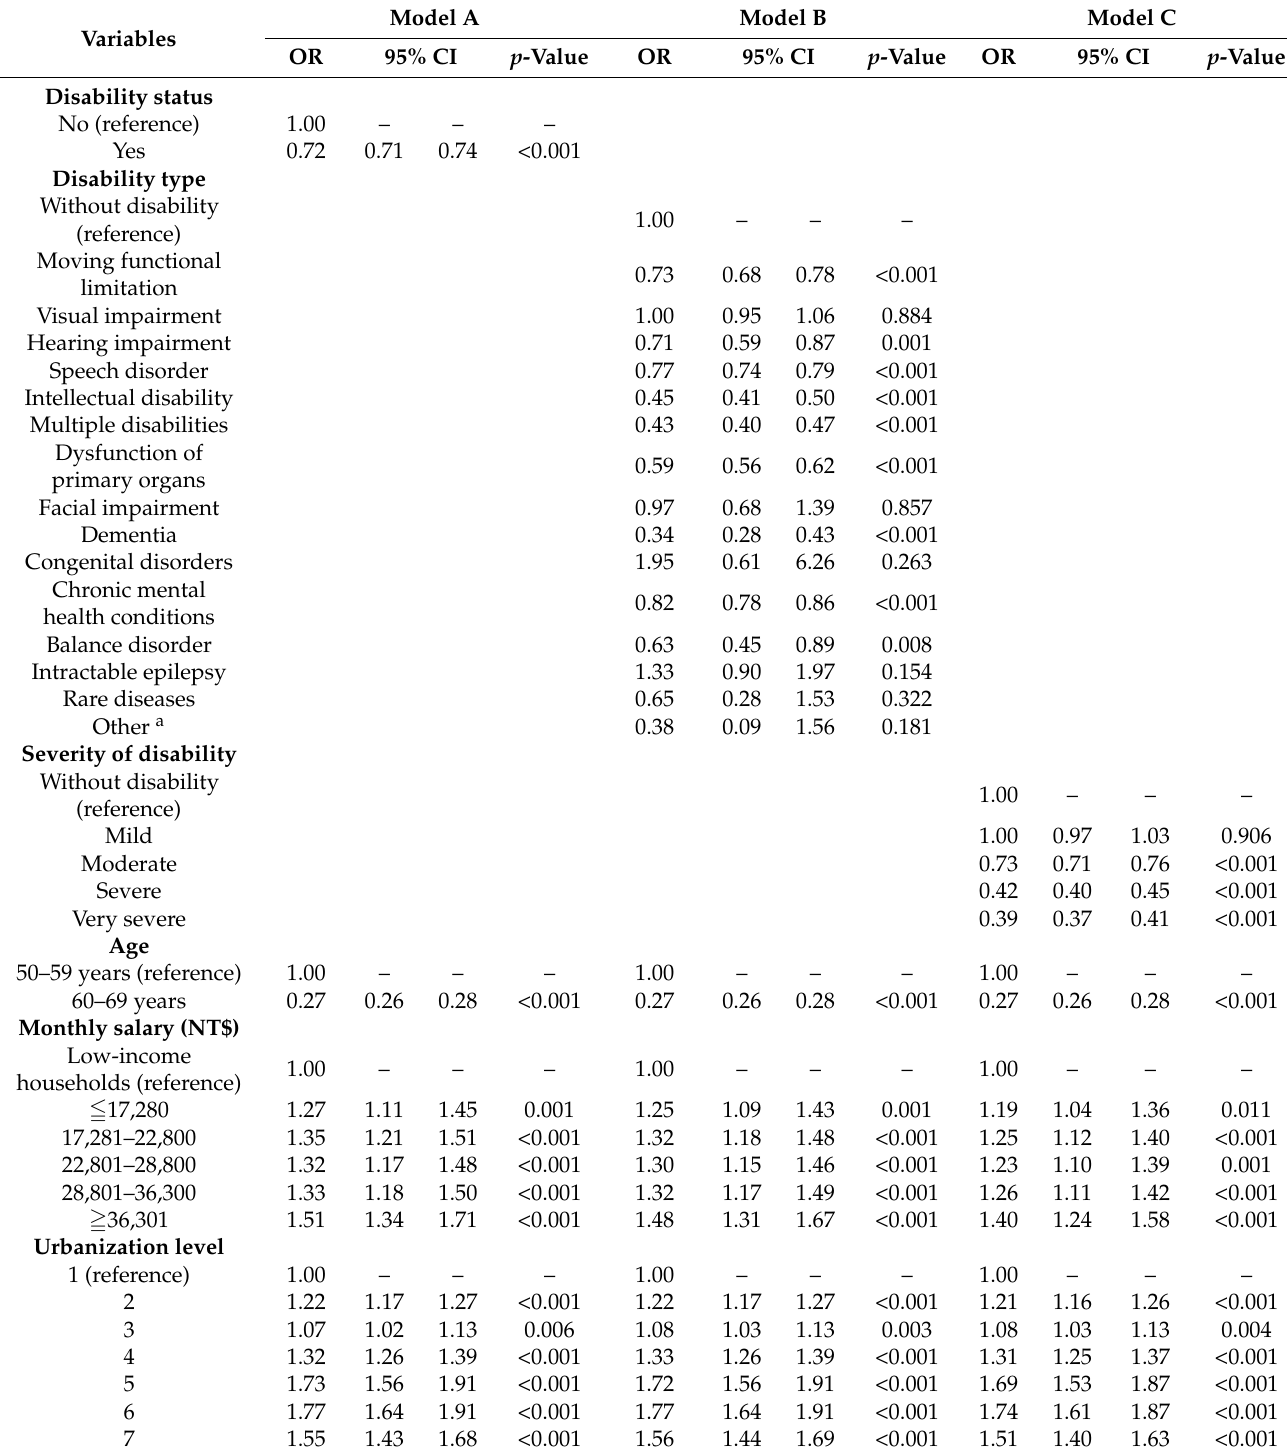
Table 3. Relevant factors affecting the use of breast cancer screening for women with disabilities and those without disabilities (conditional logistic regression